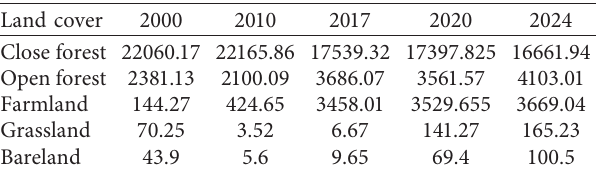
Table 15: 2020 and 2024 predicted forest cover areas in hectares (ha) in the